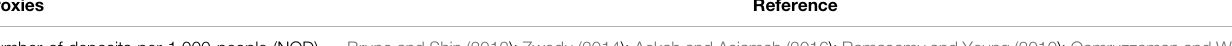
TABLE 2 | Financial inclusion proxy and reference table. Proxies Reference